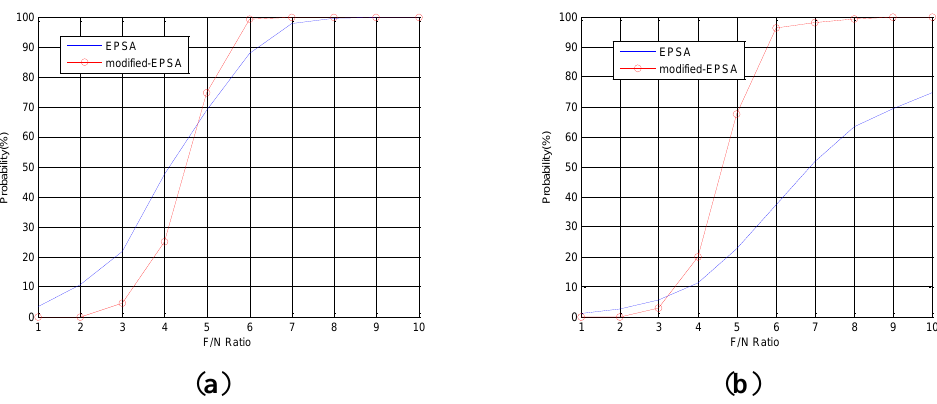
Figure 13. (CASE2) Double faults detection and isolation performance of sensor 1. ( a ) Detection probability. ( b ) Isolation probability.